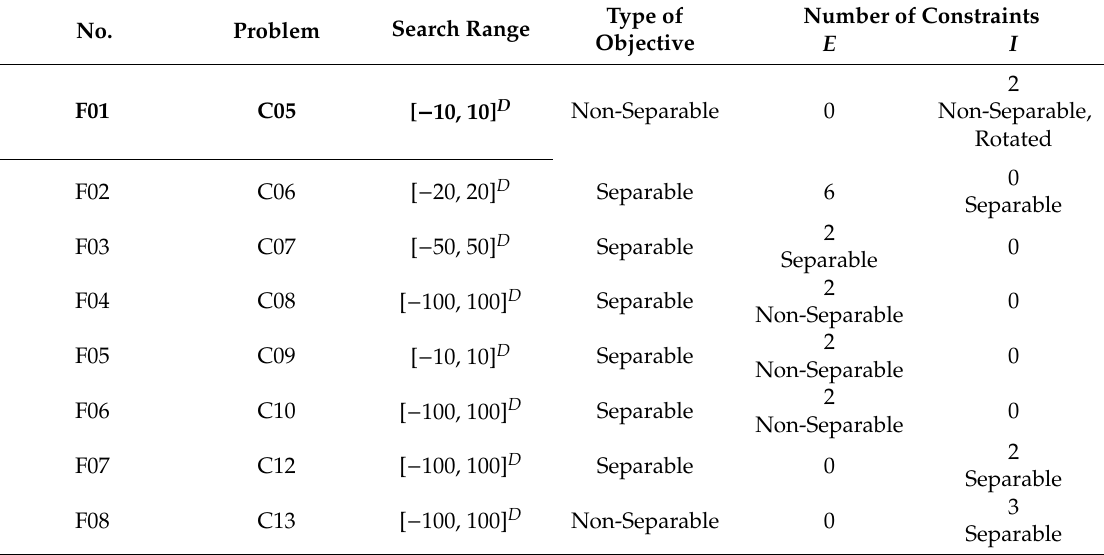
Table 13. Details of 14 Congress on Evolutionary Computation (CEC) 2017 constrained functions. D is the number of decision variables, I is the number of inequality constraints, and E is the number of equality constraints.